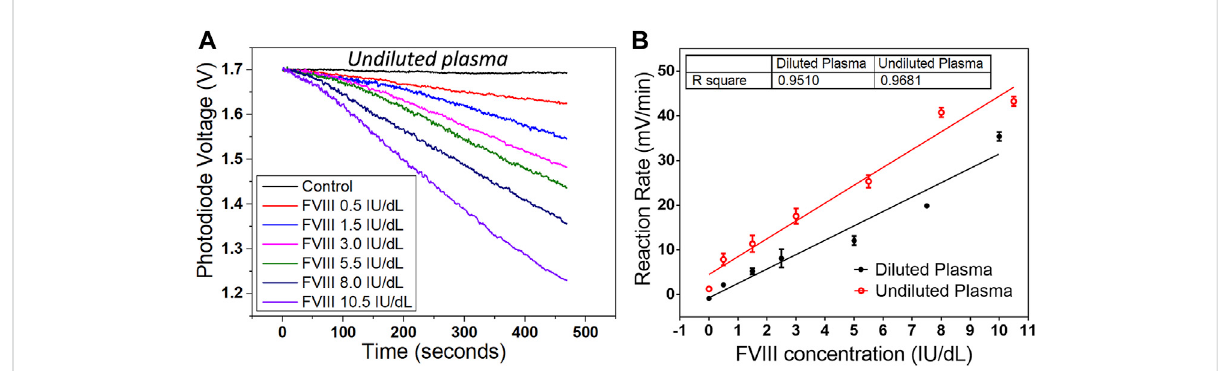
FIGURE 7 Result fromundiluted plasma on thesensing platform. (A) Reaction curves from six concentrations ofundiluted plasma samples onthe sensing platform with one-step chromogenic approach. (B) Comparison of the reaction rates between the diluted and undiluted plasma for the fi rst 3 min. The undiluted plasma shows a slightly faster reaction rate and a better linearity. Data are the mean ± SEM with three repeated